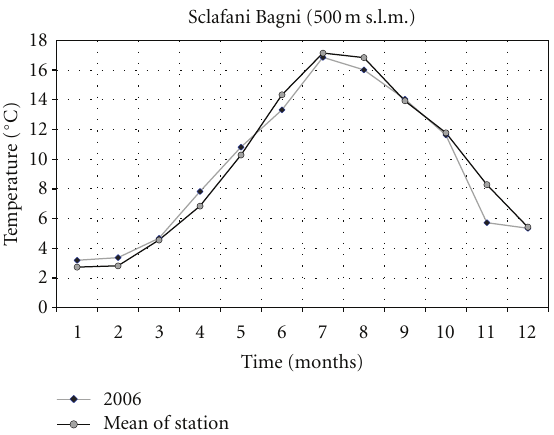
Figure 4: Daily minimum temperature trend in 2001 compared with the mean trend registered in the thermopluviometric